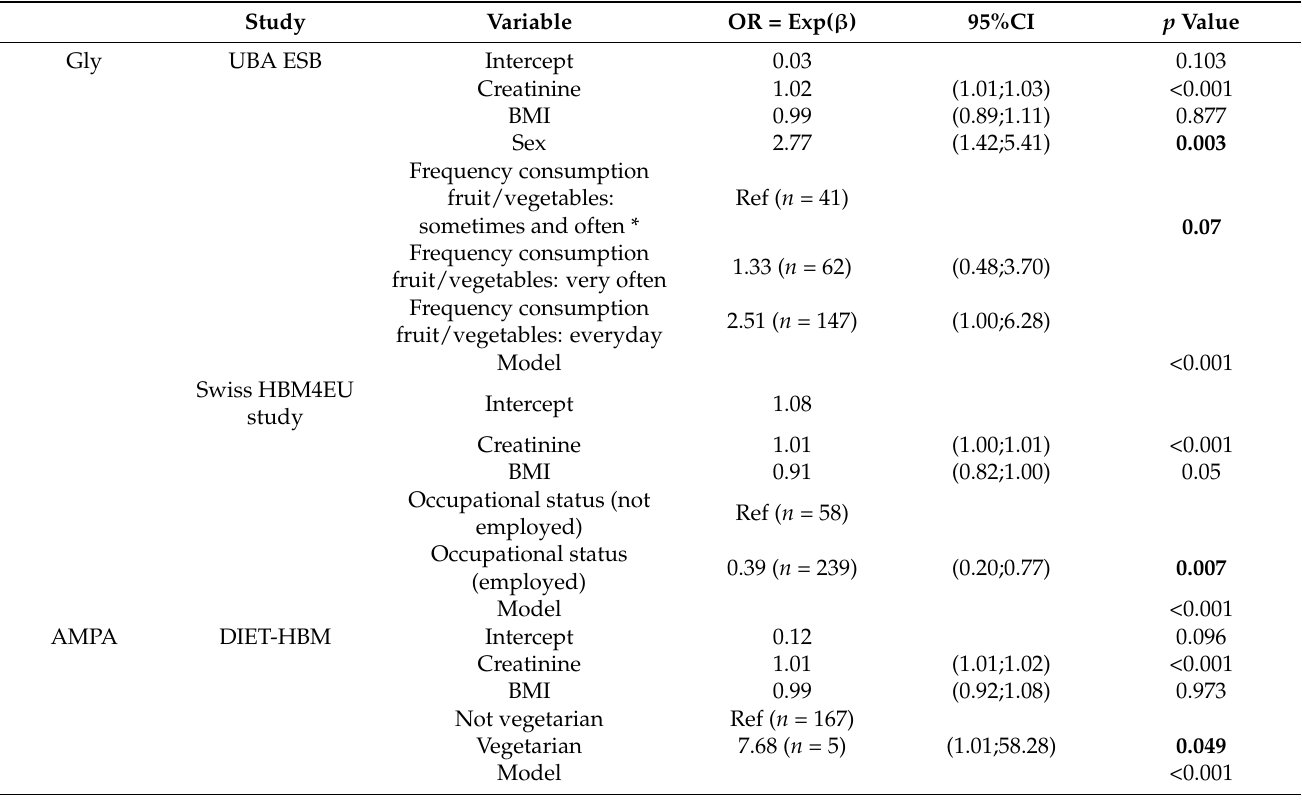
Table 5. Logistic backward multiple regression glyphosate (Gly) and AMPA HBM4EU